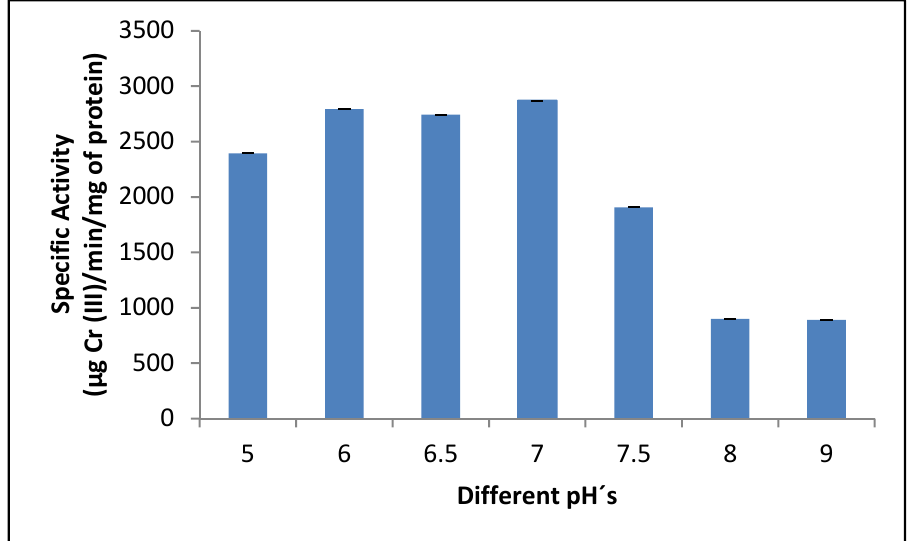
Figure 2. Effect of pH on crude reductant activity in the mixed membrane fraction of Purpureocillium lilacinum determined in different buffers (pH 5.0–9.0) at 37 °C, 1 h of incubation, and 100 rpm.